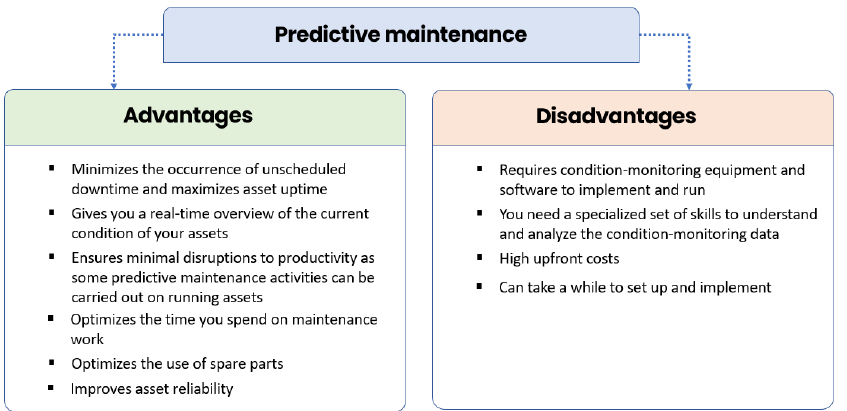
Figure 1. Advantages and disadvantages of predictive maintenance. Table 1. The industrial